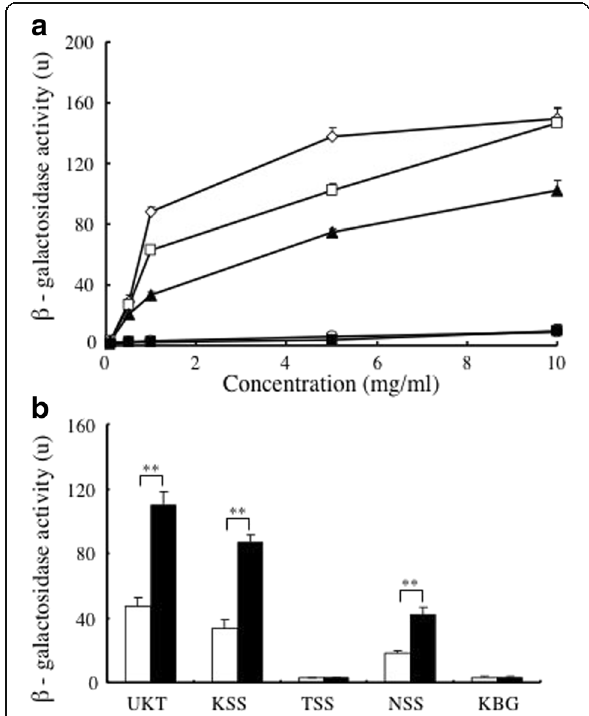
Fig. 2 The ER β -dependent estrogenic activity of the Japanese herbal medicines and the metabolized herbal medicines in the yeast two- hybrid assay. a Yeast cells that had been transfected with hER β were incubated with 0.1 mg/ml to 10 mg/ml of UKT ( ◊ ), KSS ( □ ), TSS ( ○ ), NSS ( ▲ ), or KBG ( ■ ) for 4 h at 30°C. ER β -dependent estrogenic activity was evaluated based on the β -galactosidase activity measured at 450 nm using ONPG as a substrate. b The Japanese herbal medicines (1 mg/ml) were treated with the rat S9 fraction, and the ER β -dependent estrogenic activity of the metabolized herbal medicines (black columns) was compared with that of the unmetabolized medicines (white columns) using the yeast two-hybrid assay. **significantly increased compared with the activity of the unmetabolized medicine, p